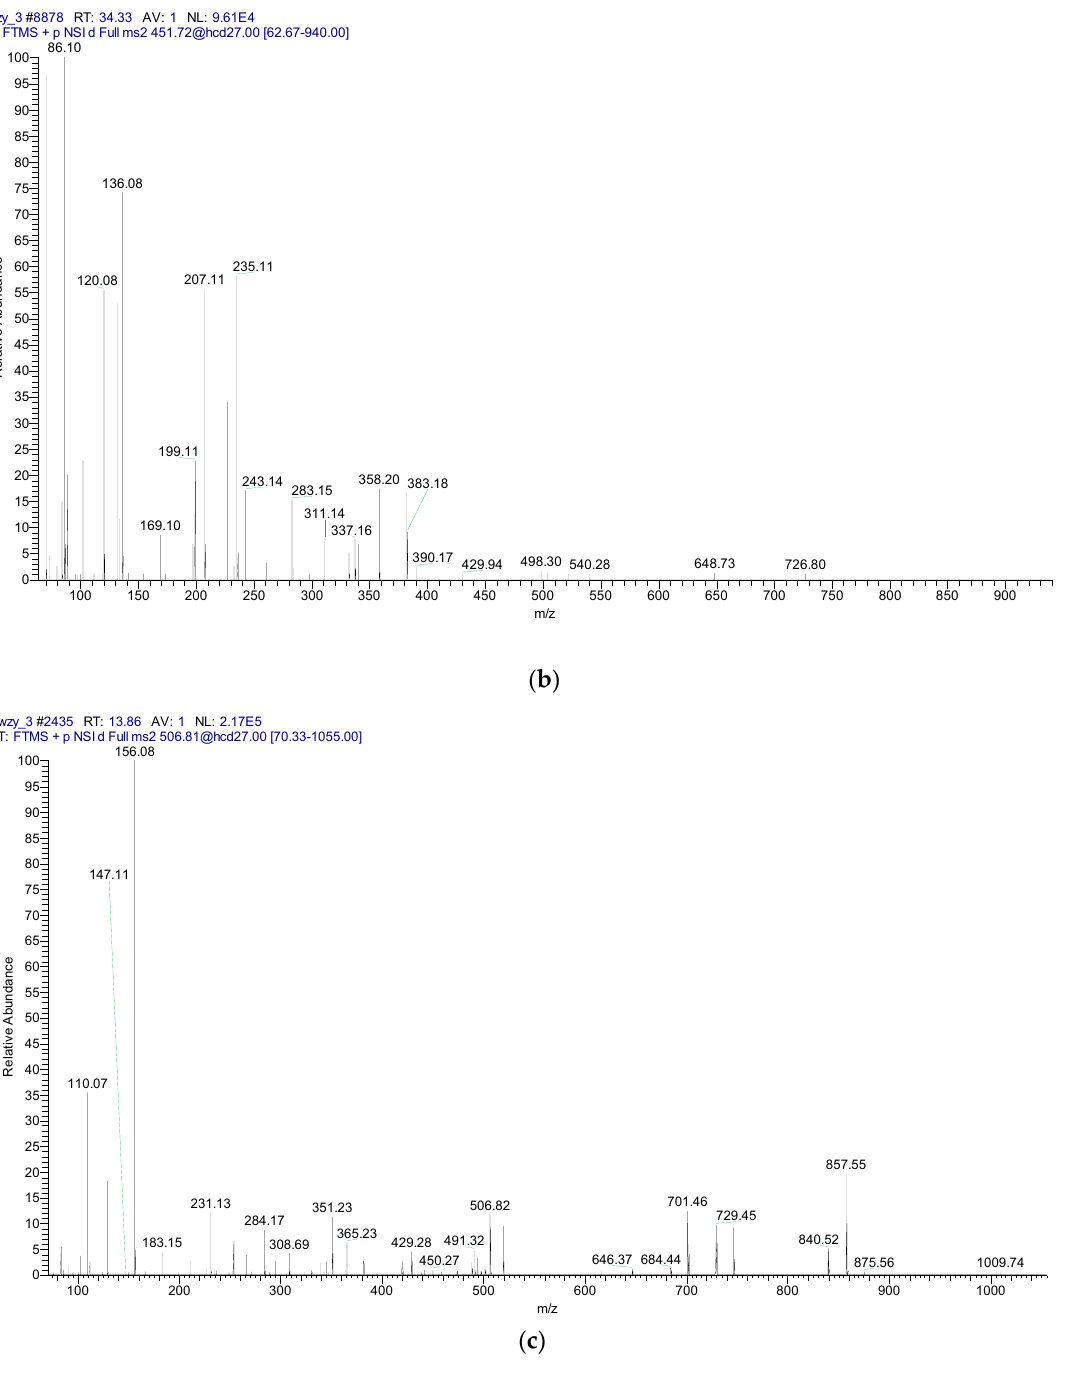
Figure 8. RYPLGYL, KHPIK, and FFSDK LC-MS result analysis. ( a ) LC/MS of RYPLGYL passing through membrane liquid. ( b ) LC/MS of KHPIK passing through membrane liquid. ( c ) LC/MS of FFSDK passing through membrane liquid. Table 4. KHPIK hydrolysis after mass spectrometry sequence.